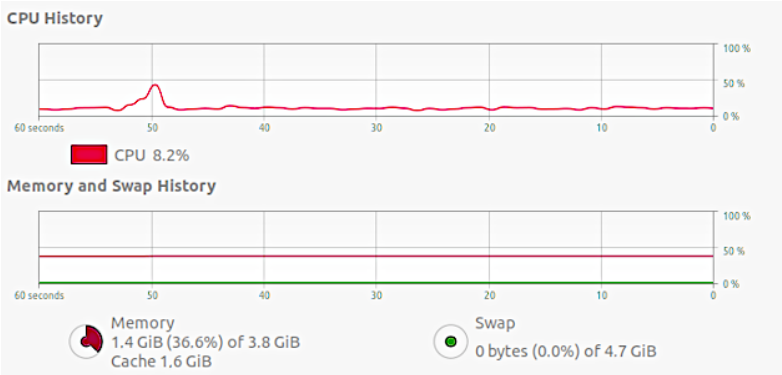
Figure 10. CPU and memory usage in one of the VMs hosting the ROADM